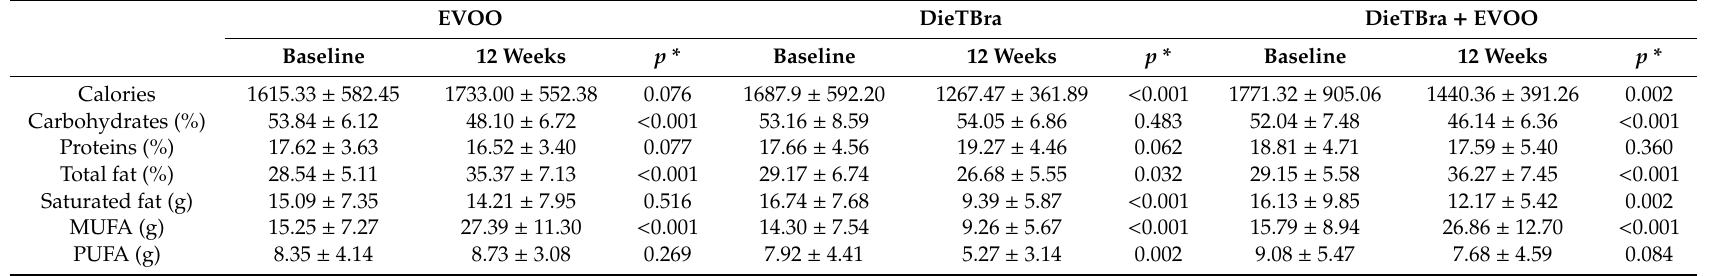
Table 4. Changes in caloric and macronutrient intake during the study